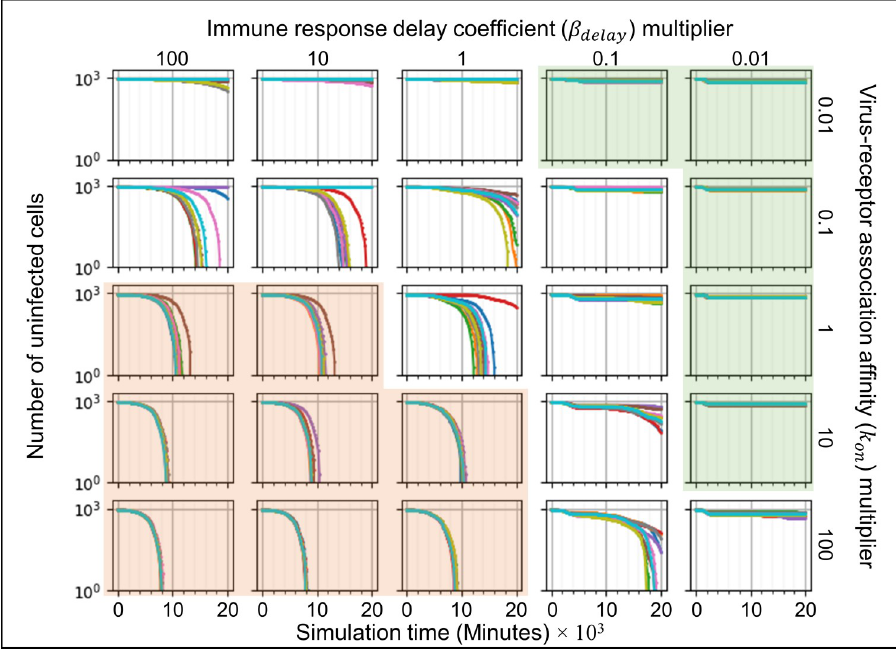
Fig 5. Sensitivity analysis of the number of uninfected epithelial cells vs time for variations in virus-receptor association affinity k and immune response delay coefficient β , showing regions with distinct infection on delay dynamics. Logarithmic pairwise parameter sweep of the virus-receptor association affinity k and the immune on response delay β delay ( × 0.01, × 0.1, × 1, × 10, × 100) around their baseline values, with ten simulation replicas per parameter set (all other parameters have their baseline values as given in Table 1). The number of uninfected epithelial cells for each simulation replica for each parameter set, plotted on a logarithmic scale, vs time displayed in minutes. See Fig 4 for the definitions of the classes of infection dynamics.